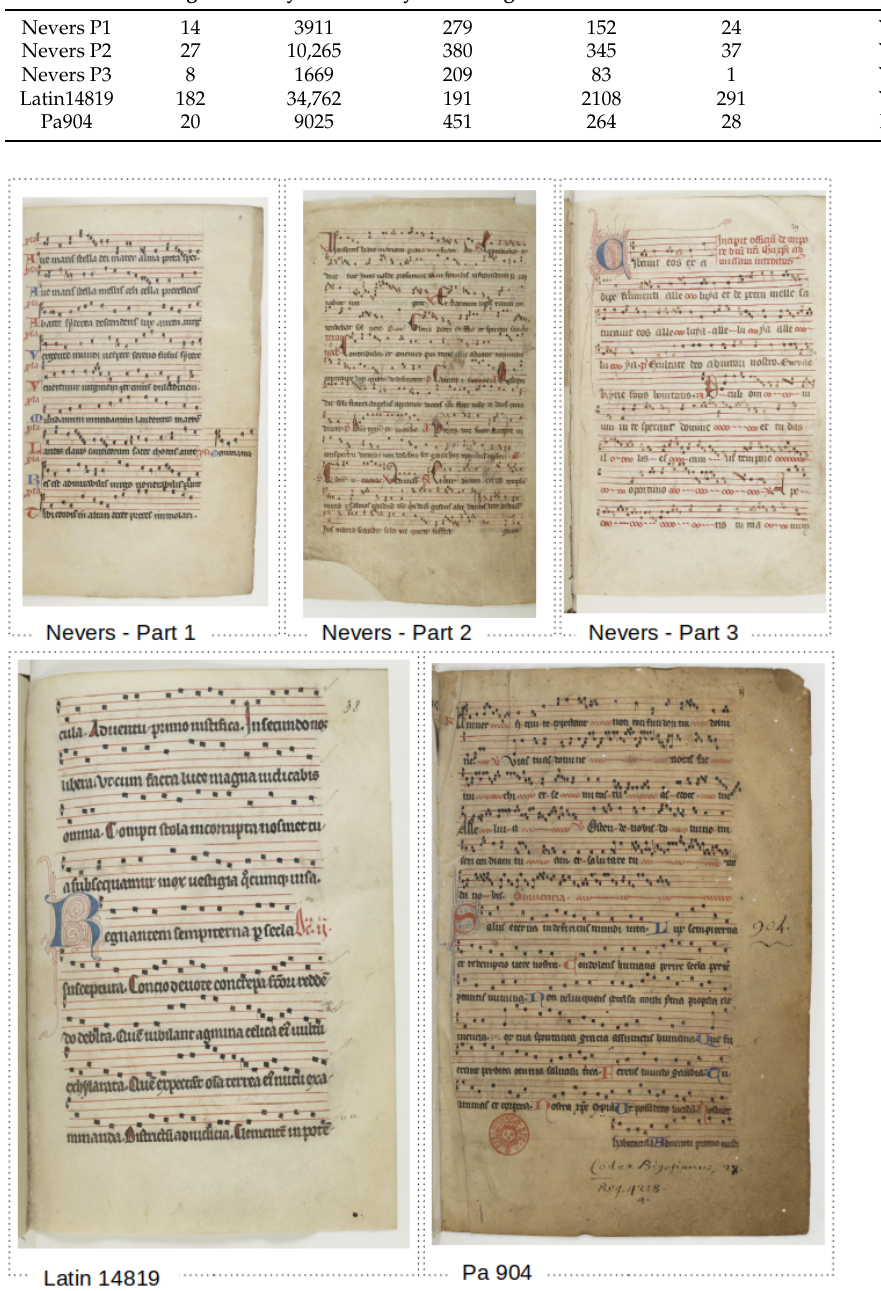
Figure 2. Sample example pages for the used